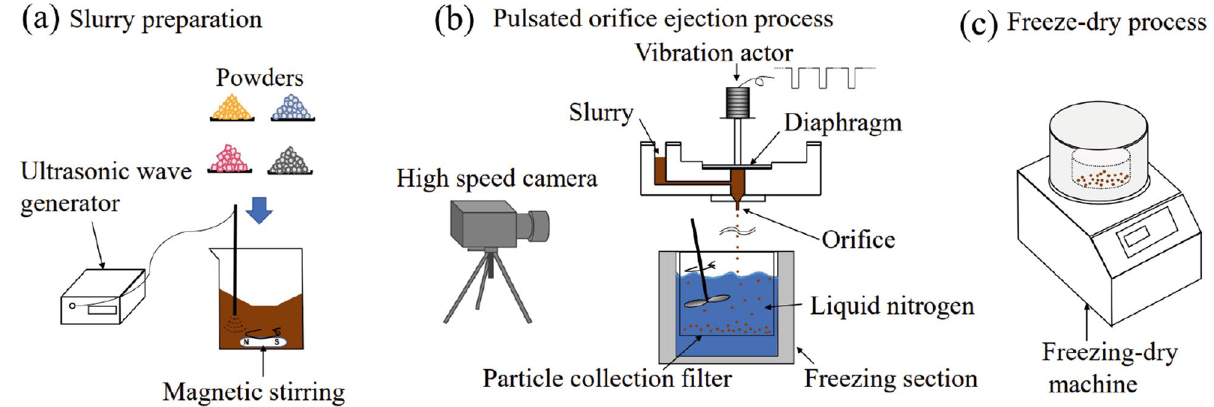
Figure 1. Schematic diagram of FD-POEM process: ( a ) Fabrication process of the slurry; ( b ) Preparation of composite particles by pulsated orifice ejection method; ( c ) Freeze-drying